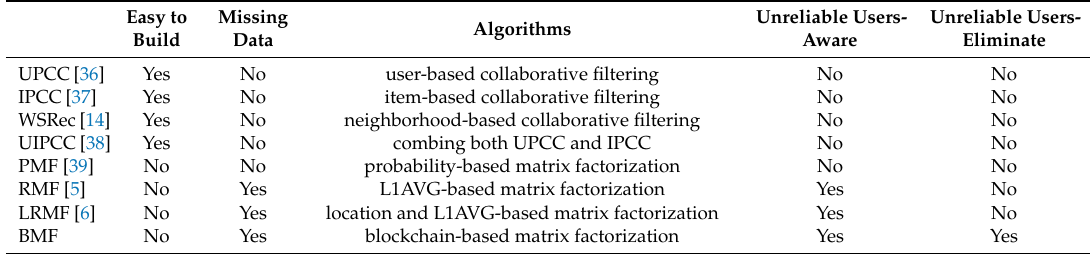
Table 1. Comparison of our approach with other